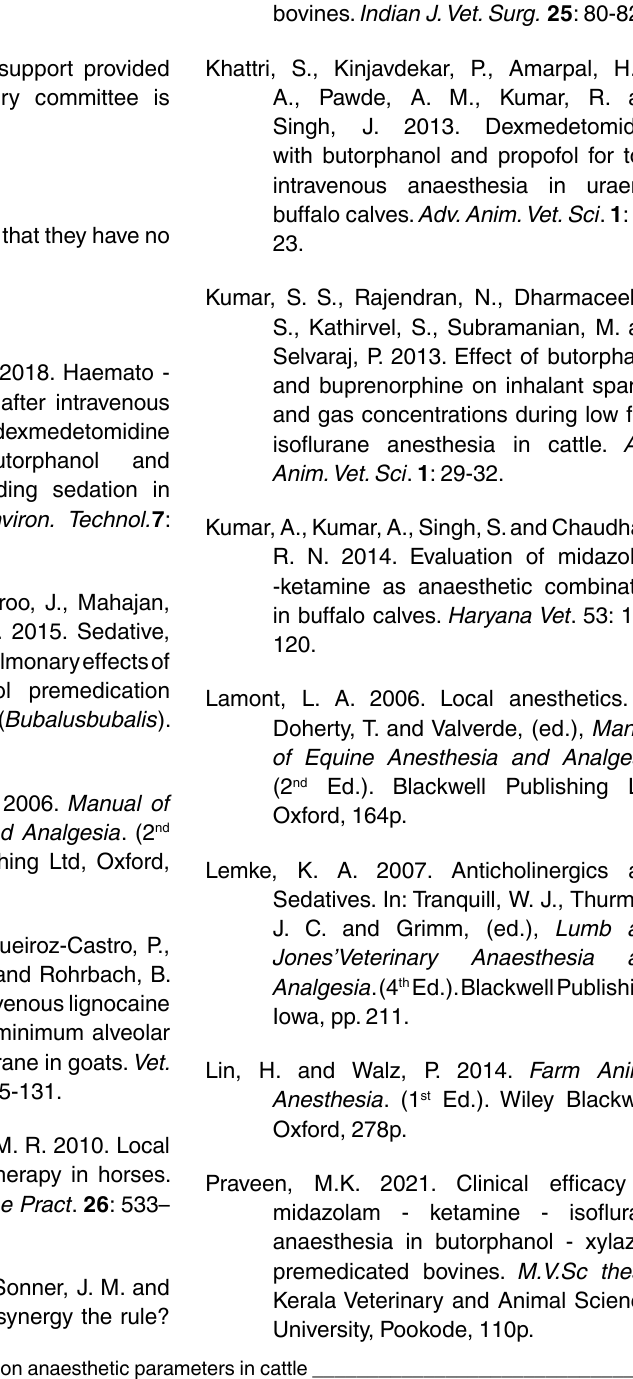
isoflurane required. The isoflurane sparing